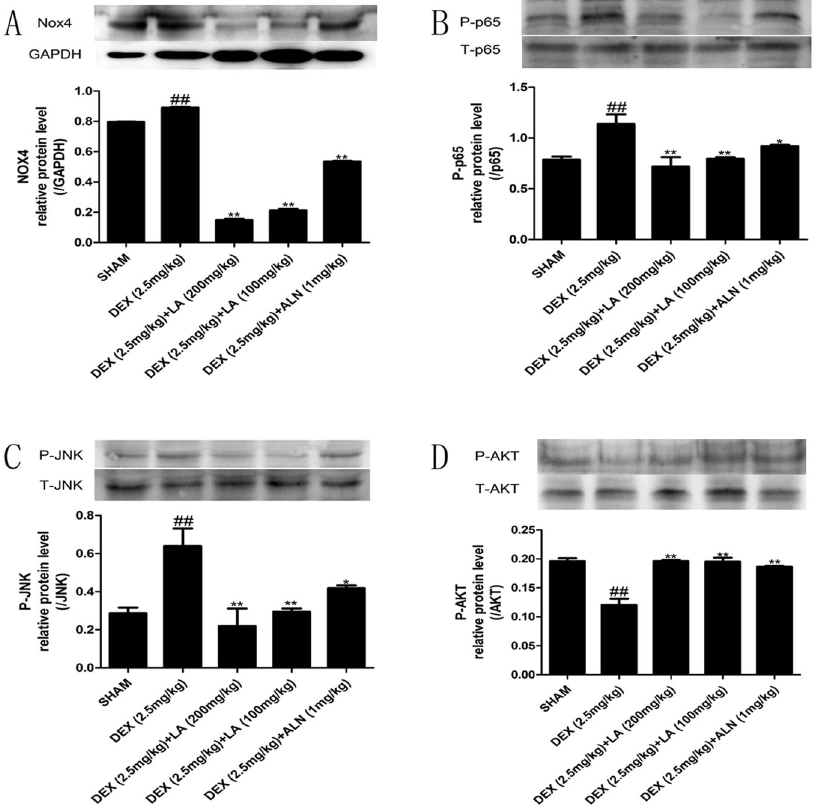
Figure 5. The protein expression levels of NOX4, NF-kappaB, JNK and the PI3K/AKT signalling pathway on femur. Nox4 ( A ), levels of phosphorylation of p65 ( B ), levels of phosphorylation of JNK ( C ) and levels of phosphorylation of AKT ( D ) were detected by western blotting. Data were the means ± SD (n = 6 for each group). # p < 0.05 and ## p < 0.01 compared with the SHAM group. * p < 0.05 and ** p < 0.01 compared with the DEX group. GAPDH was used as loading